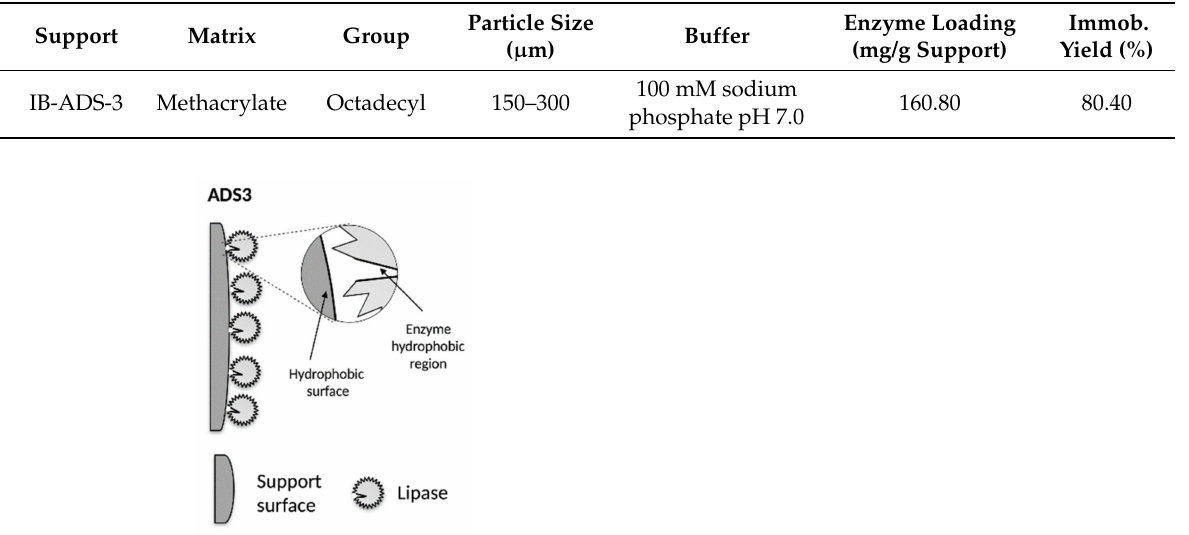
Table 1. Summary of immobilized derivative properties.